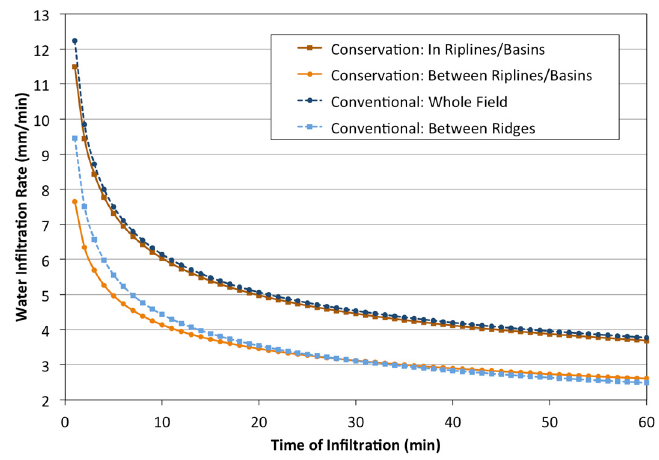
Figure 2. Mean water infiltration rates converted to best-fit power function for different field locations.